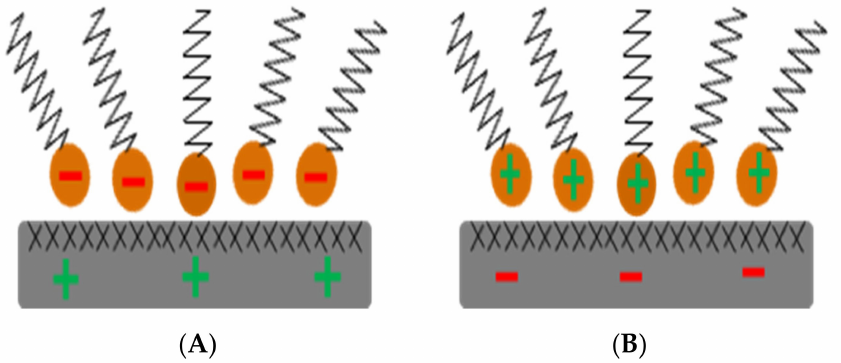
Figure 6. Surfactant adsorption by ionic change: ( A ) anionic; ( B ) cationic adapted from